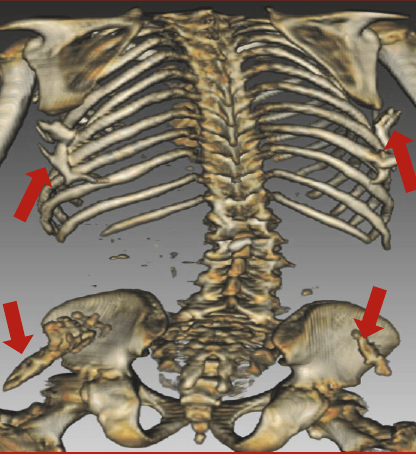
Figure 4: Three-dimensional reconstruction CT: presence of extraskeletal ossifications of the posterior surface of the trunk and the posterior surface of the iliac wings (red